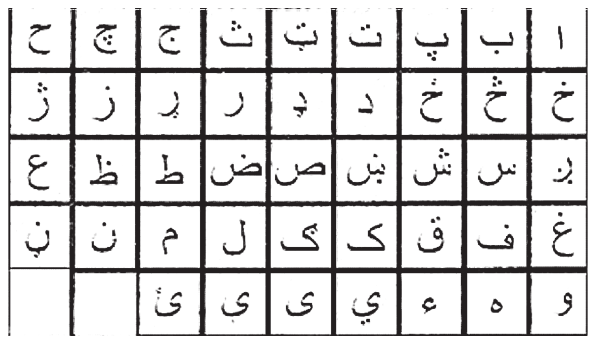
Figure 3: Pashto character